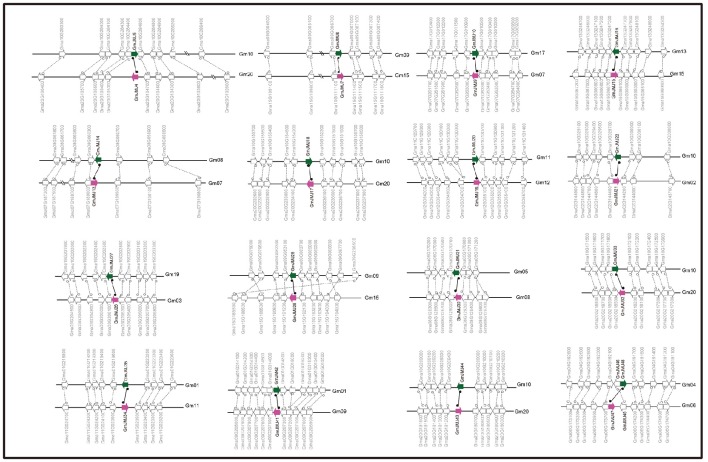
Collinearity analysis of duplicated gene pairs formed by Glycine-specific WGD event. Green and purple arrows represented duplicated JmjC gene pairs. The direction of the arrow indicates the position of the gene in the positive (to left) and negative (to right) chain of DNA.